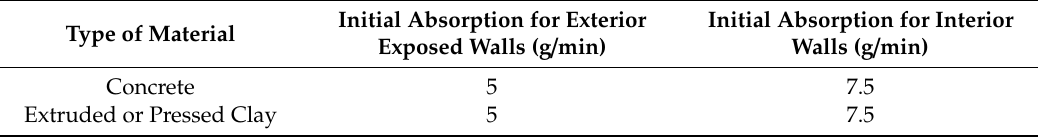
Table 6. Initial maximum water absorption values for Mexican